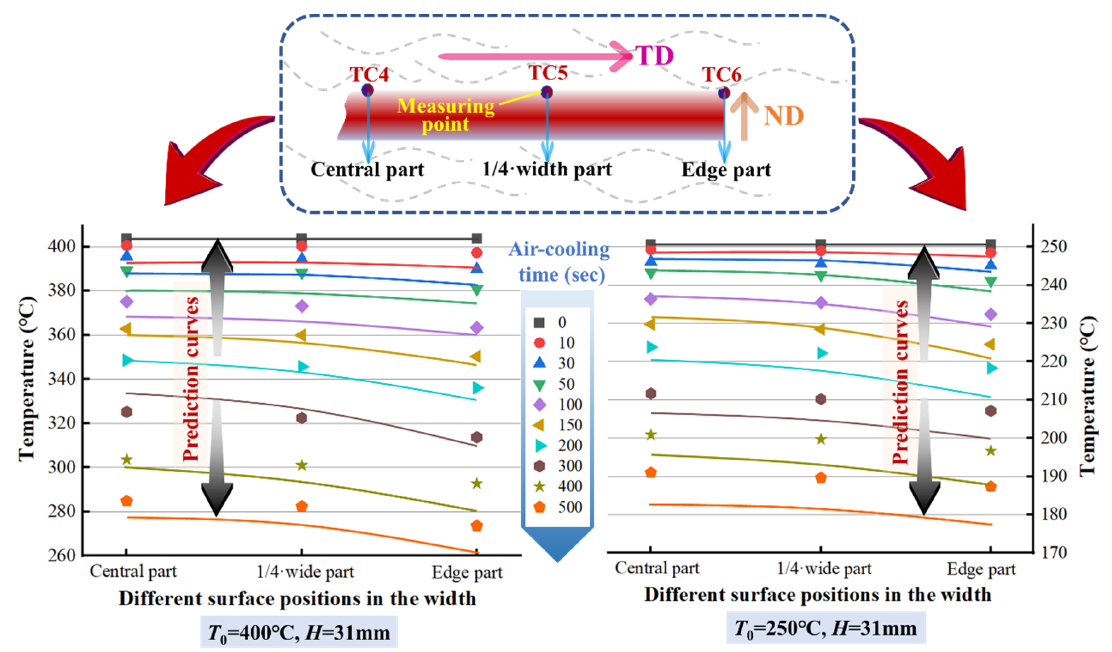
Figure 9. Comparison between calculated and experimental temperatures at different width positions during the air-cooling process under 400 °C–31 mm and 250 °C–31 mm.